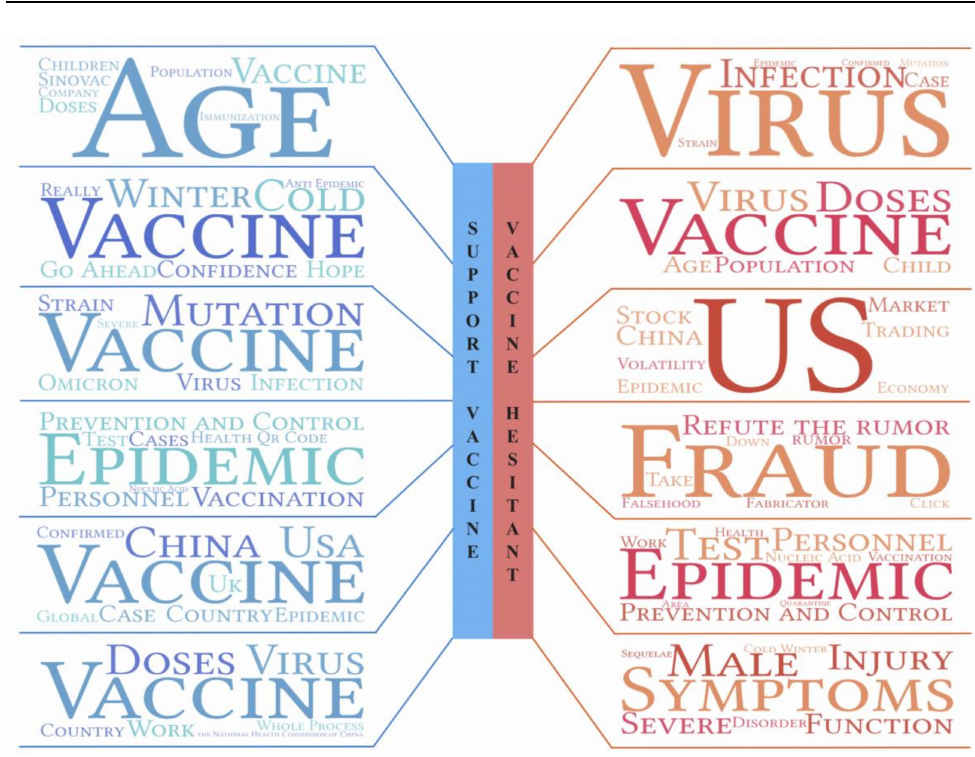
Figure 8. The topic keywords of vaccine-hesitant and vaccine-support groups